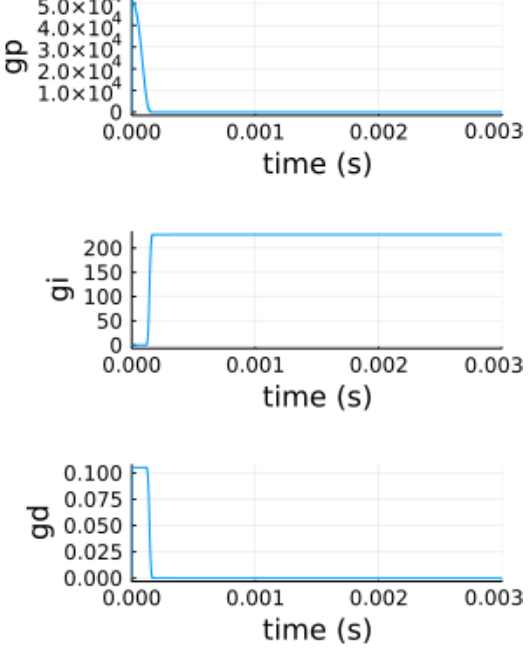
Figure 6. Variation of the adaptive gains of the controller (obtained by PSO optimization) during the initial transition.